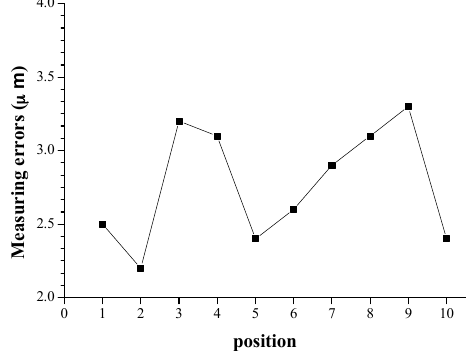
Figure 10. The influence of measuring position.